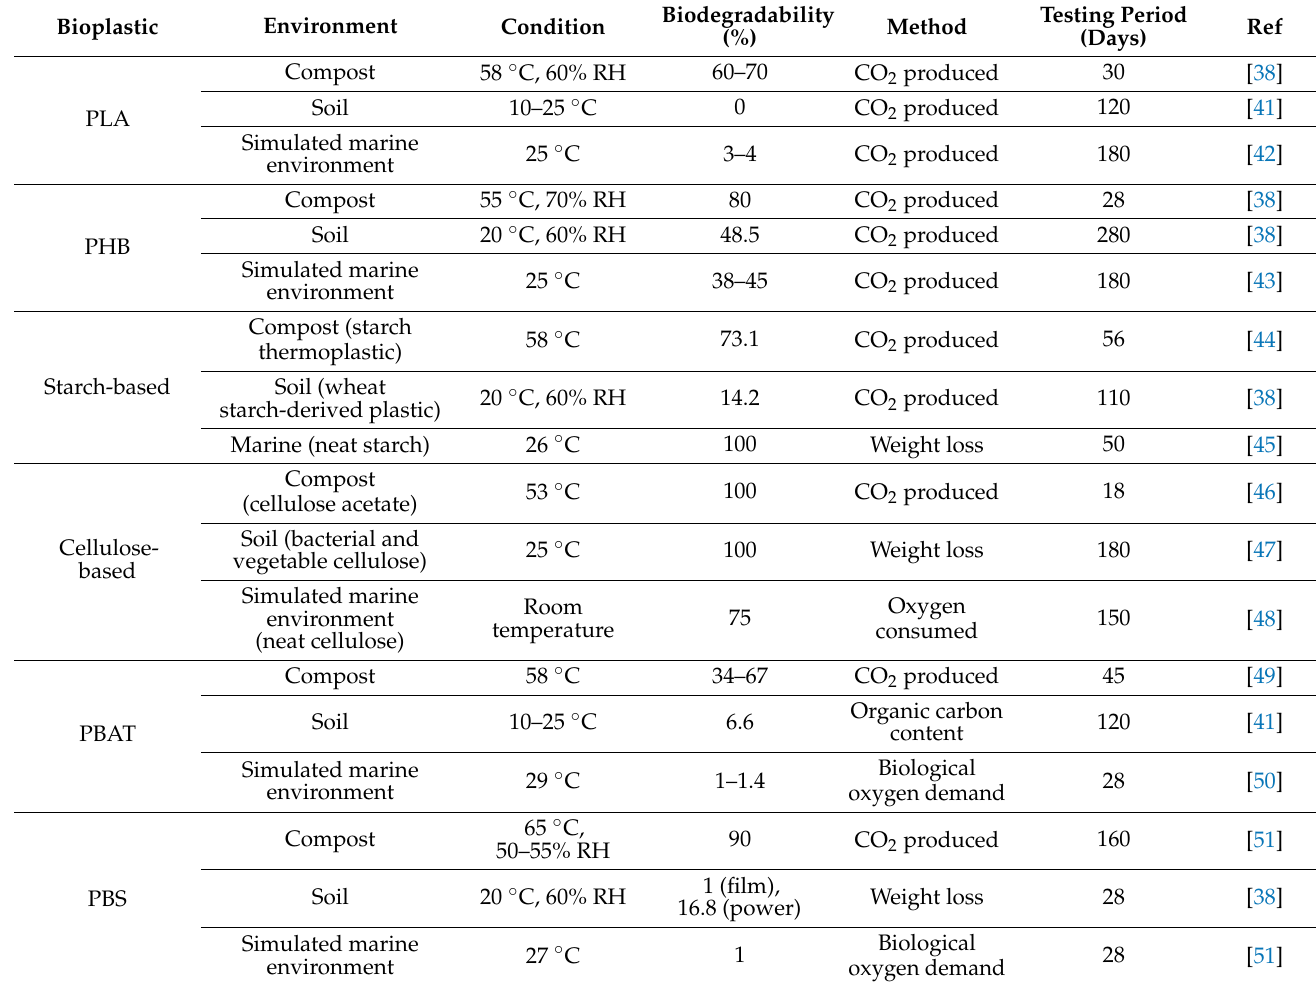
Table 1. Biodegradability of bioplastics in different environments. Data adapted from [37].